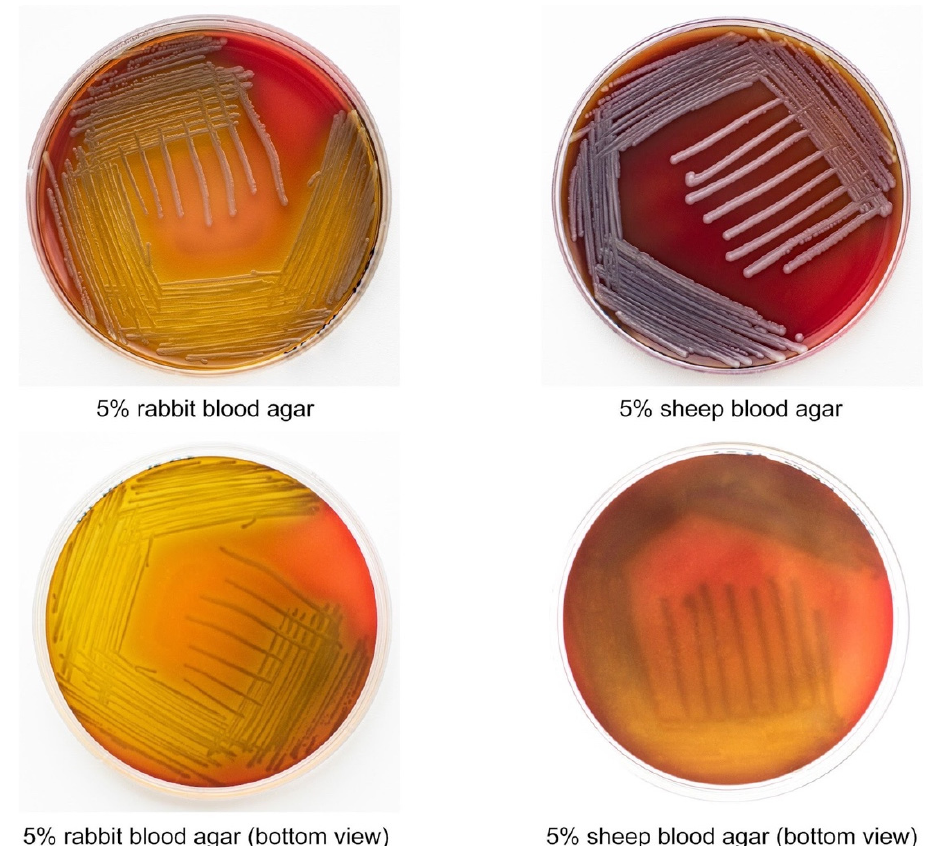
Figure 1. Elizabethkingia anophelis ML-44 on 5% rabbit blood agar and 5% sheep blood agar after 48 h of incubation.